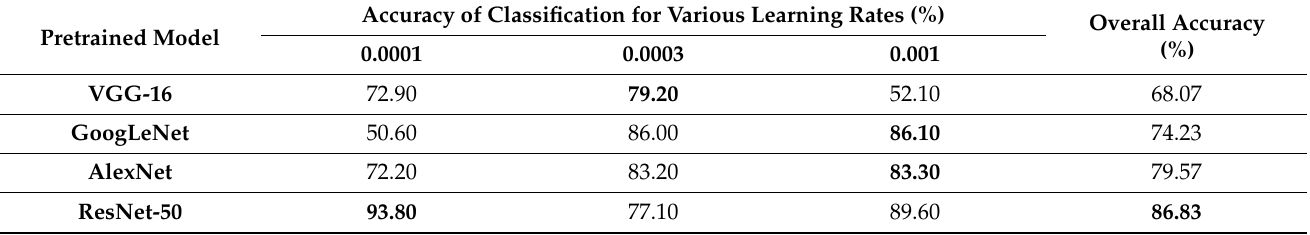
Table 5. Performance variation of pretrained networks with change in initial learning rates.